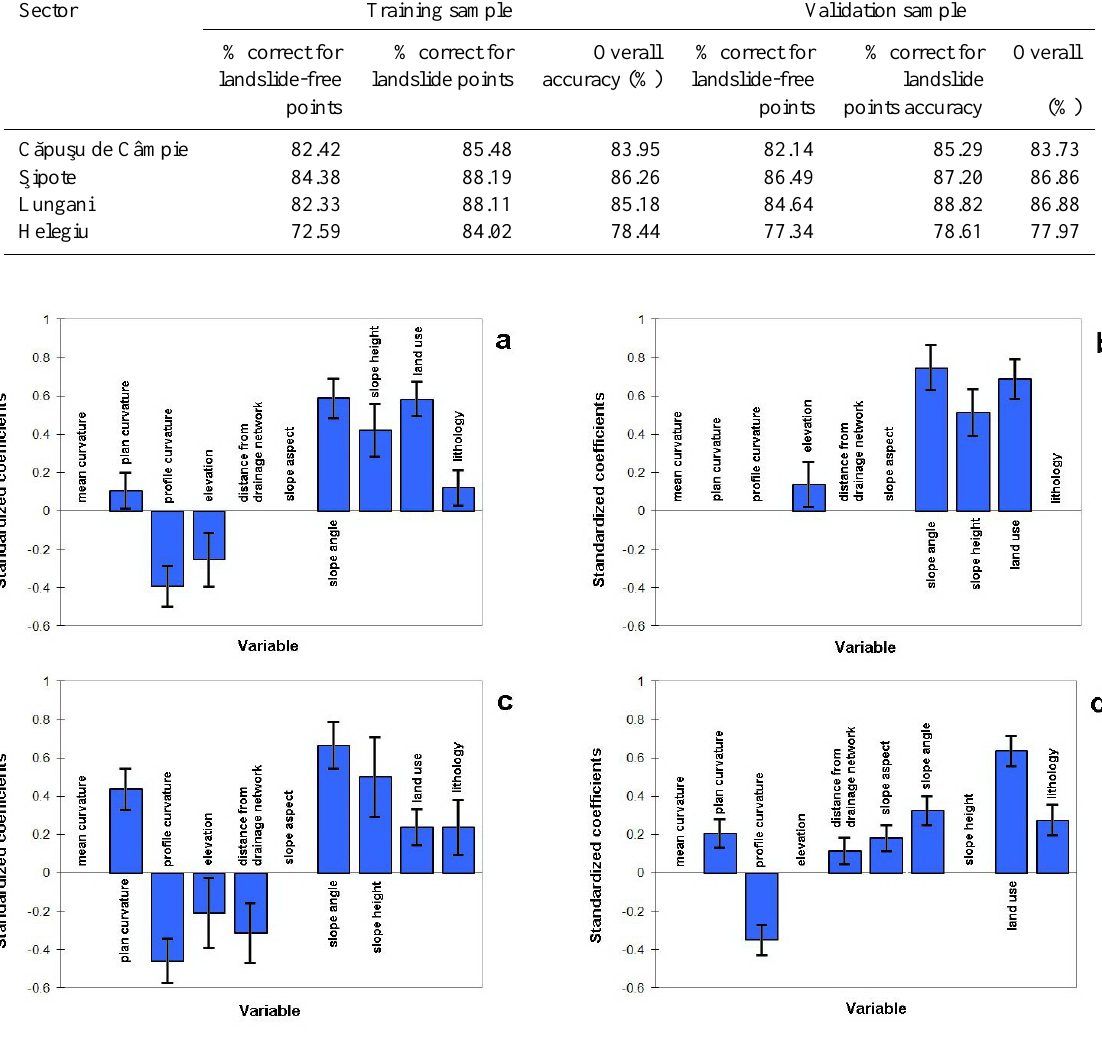
Fig. 7. Standardized coefficients’ values of predictors (with bars showing 95% confidence interval): (a) C˘apu¸su de Câmpie sector; (b) ¸Sipote sector; (c) Lungani sector; (d) Helegiu